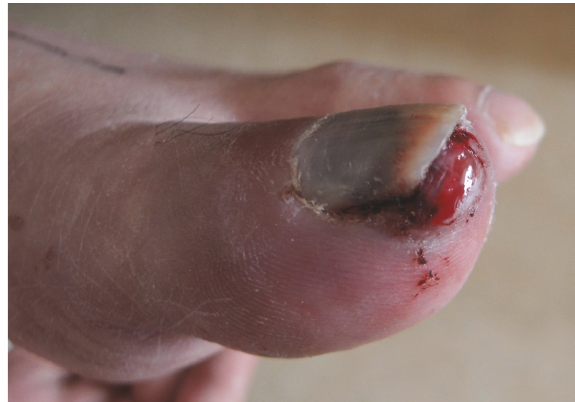
Figure 4: Photograph of the left foot. Subungual hemorrhage from the metastasis, which required a change of dressing on a daily basis, was